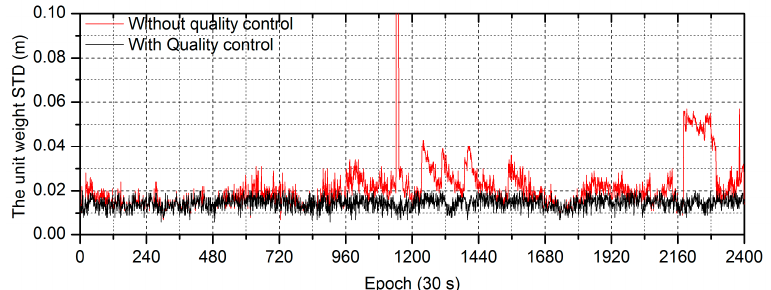
Figure 3. The unit weight STD of the single GPS PPP solution with and without quality control at station